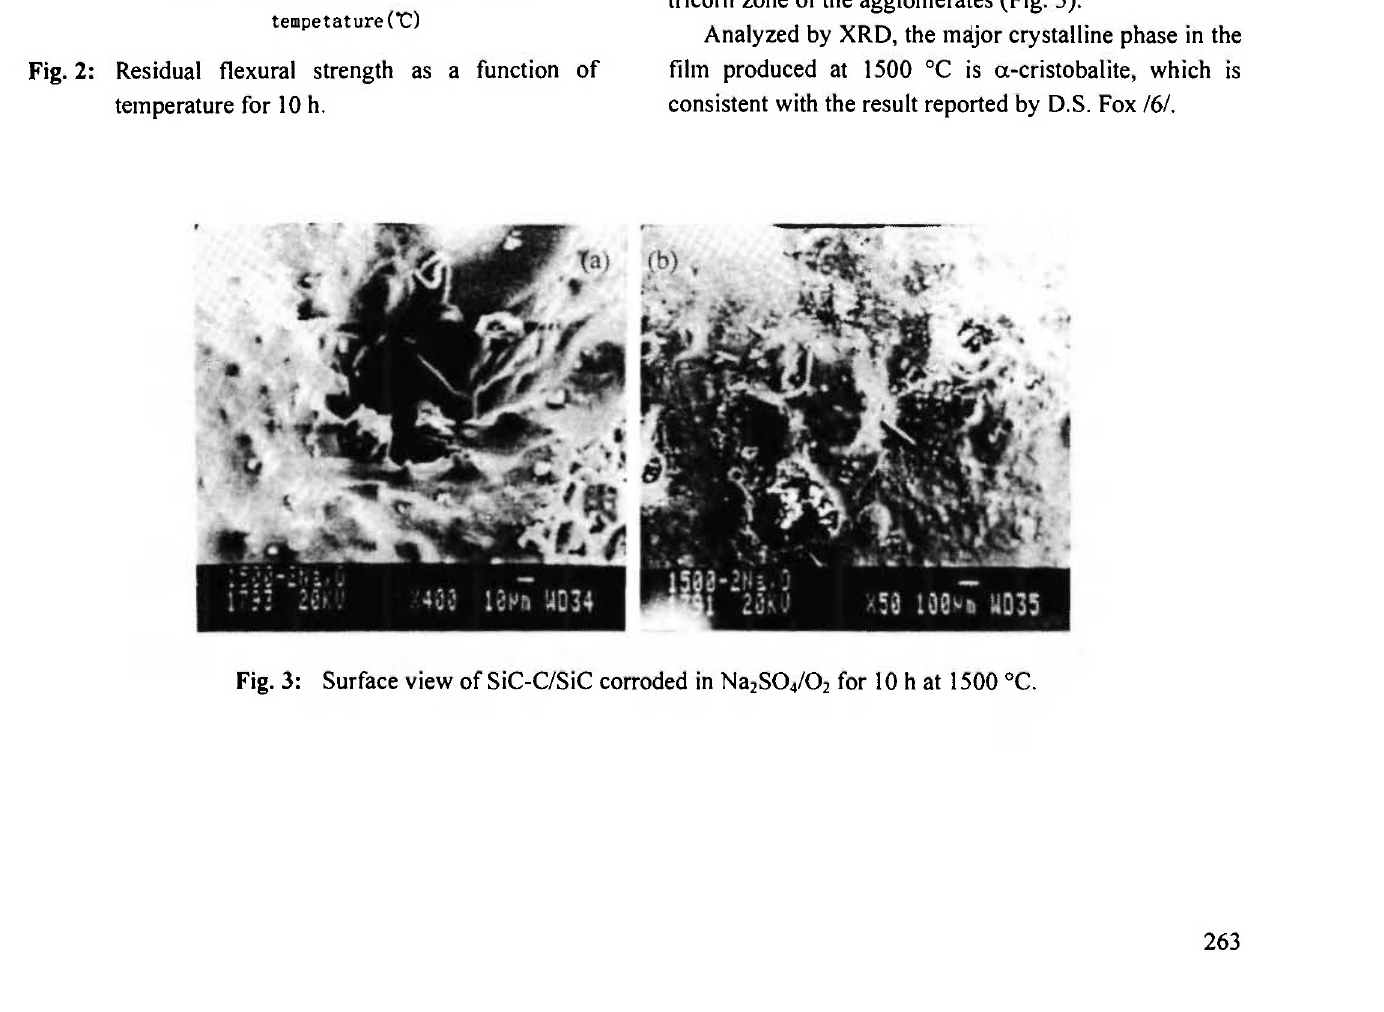
Fig. 2: Residual flexural strength as a function of temperature for 10 h.